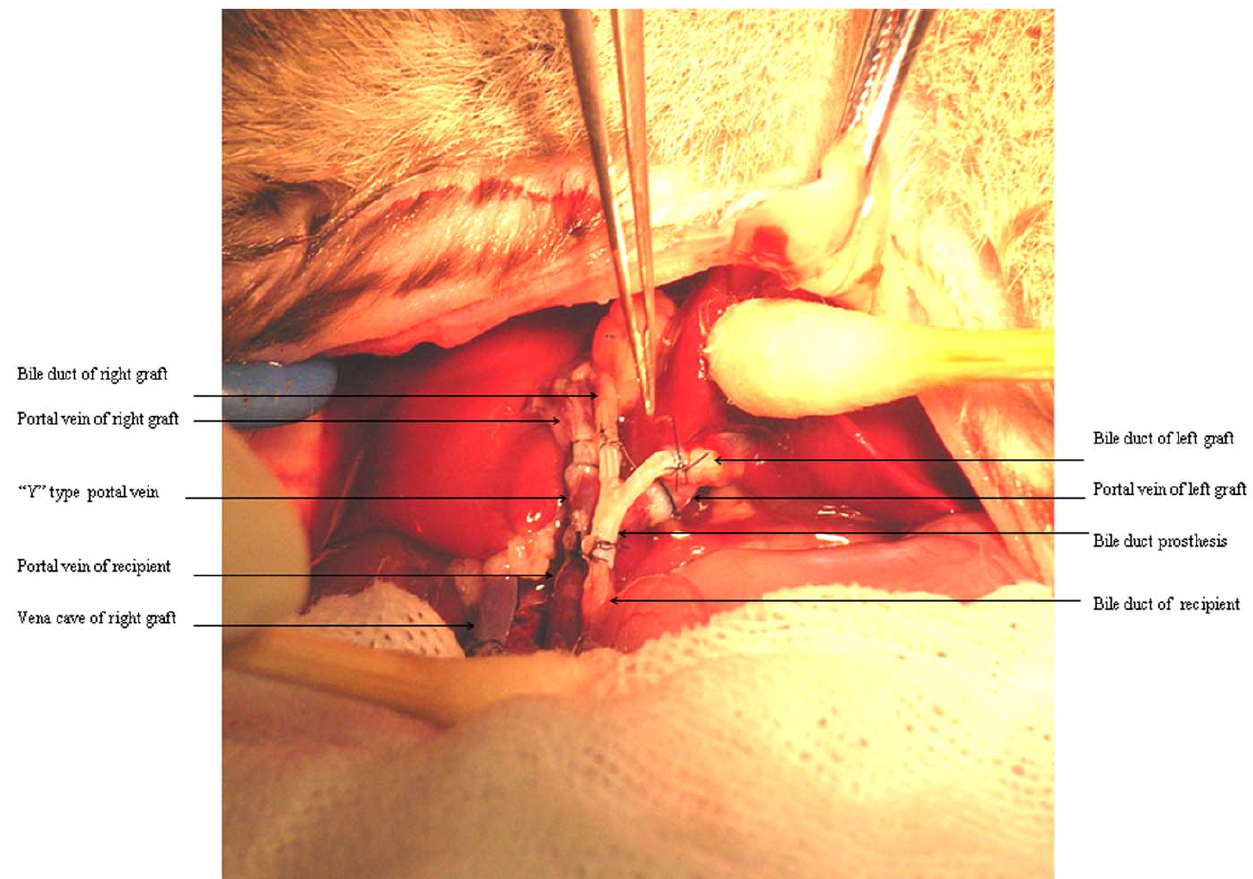
Figure 7. Y type vein and bile duct prosthesis in vivo. doi:10.1371/journal.pone.0040818.g007 PLoS ONE |